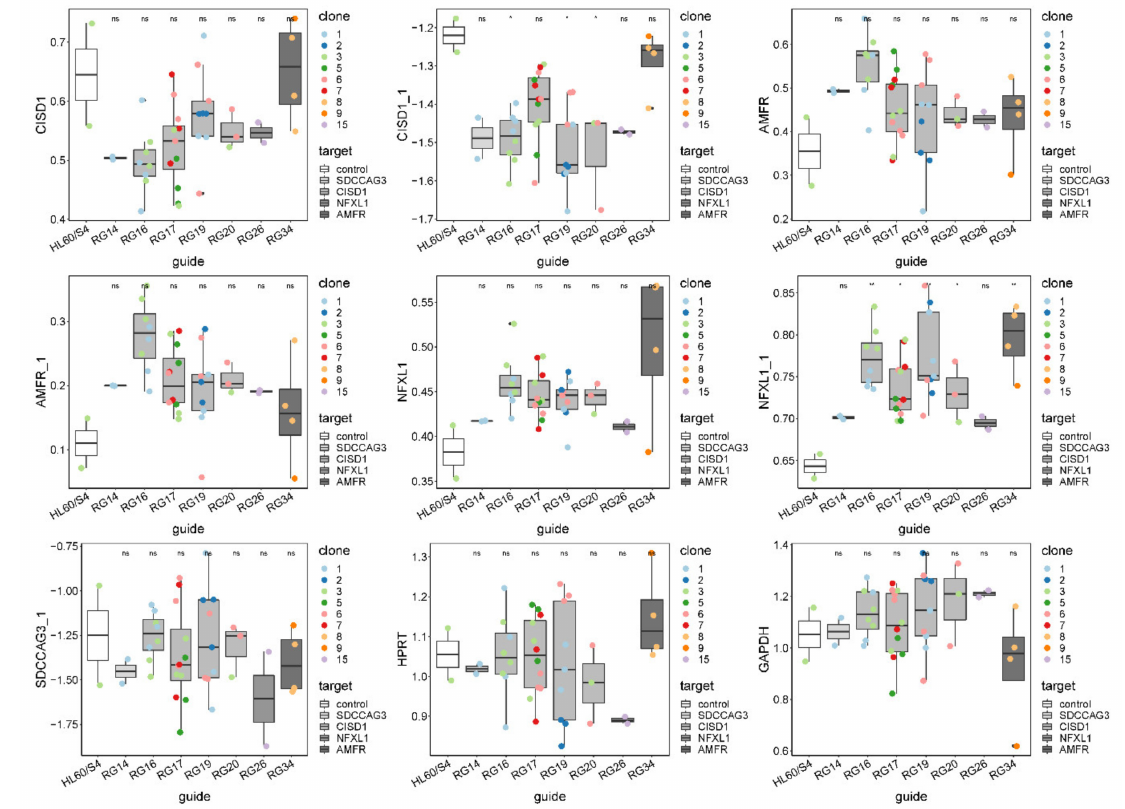
Figure 3. Quantification of all targeted gene expression in all CRISPR-Cas9-edited single-cell clones by Fluidigm qRT-PCR (Tables S1 and S2). HPRT and GAPDH are housekeeping controls. Single-cell clones were grouped by guide RNA, and the expression of seven probes is shown as boxplot across all clones within each guide RNA group. Clones with the same genotype in each guide RNA group are colored-coded. A pairwise t-test was done to test the di ff erence between CRISPR-Cas9-edited clones and HL60 / S4 negative control. * denotes p -value < 0.05; ns, not